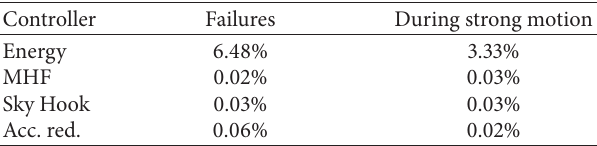
Table 3: JET-PACS: percentage malfunctions of the control system driven by different